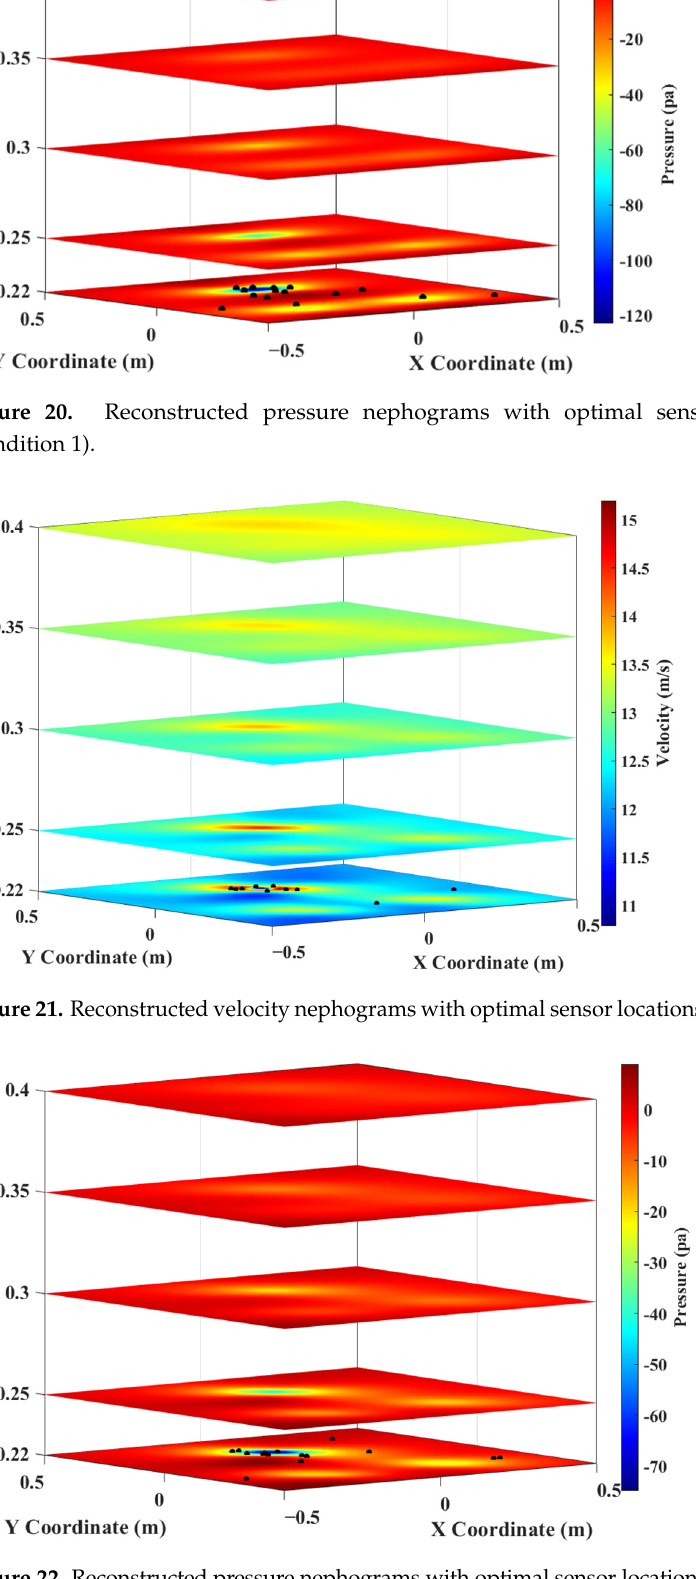
Figure 22. Reconstructed pressure nephograms with optimal sensor locations (Boundary Condition 2).